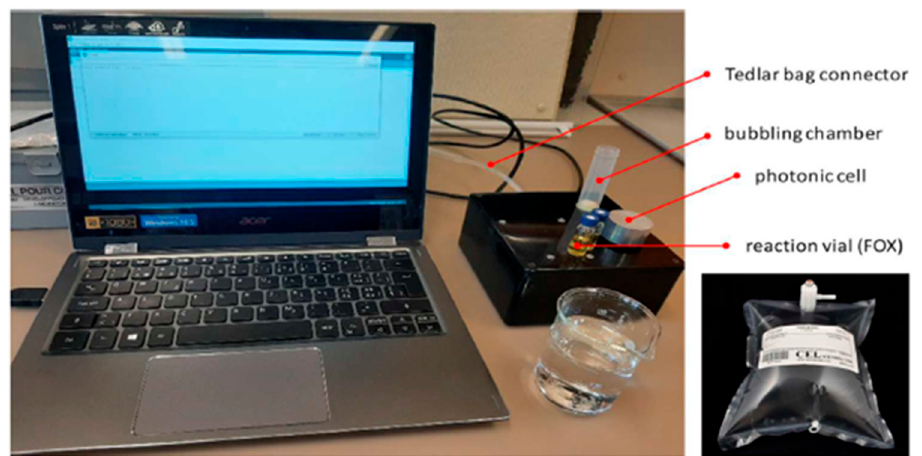
Figure 1. Experimental setup for the determination of OPEA. The setup comprises the OPEA analyzer (black box) and its different computer-driven mechanical/optical components. Disposable Tedlar bag (bottom right) was used for air sample collection (1 L).